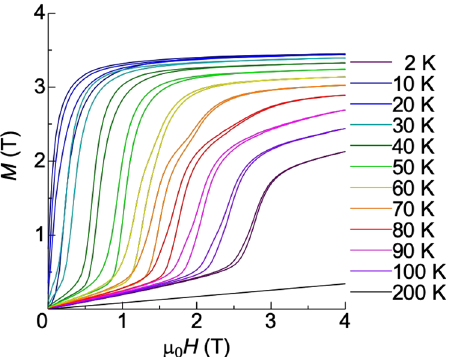
Fig. 2 Magnetization curves in holmium single crystal. The magnetic fi eld was applied along the hexagonal ½ 10 (cid:1) 10 (cid:2) direction at temperature from 2 to 200 K.